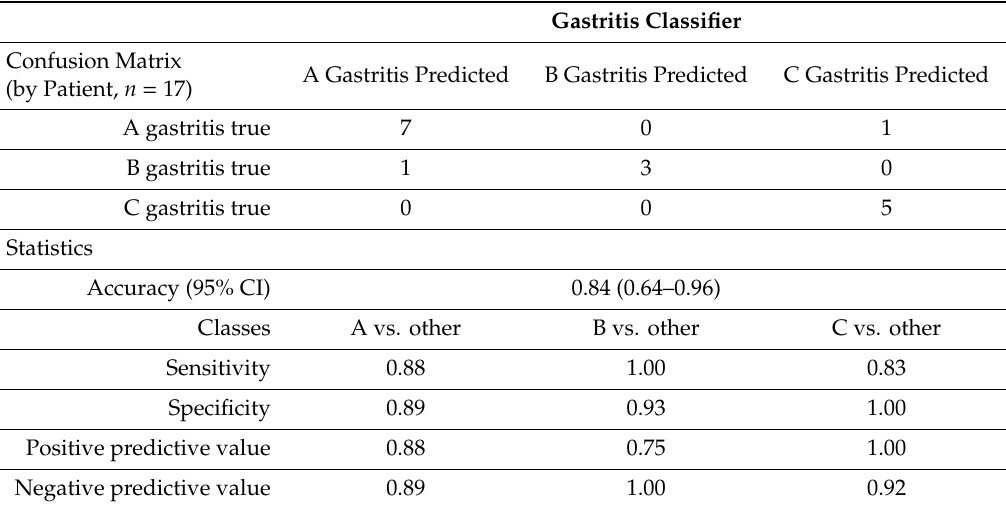
Table 4. Gastritis classifier confusion matrix and statistics for the test patient